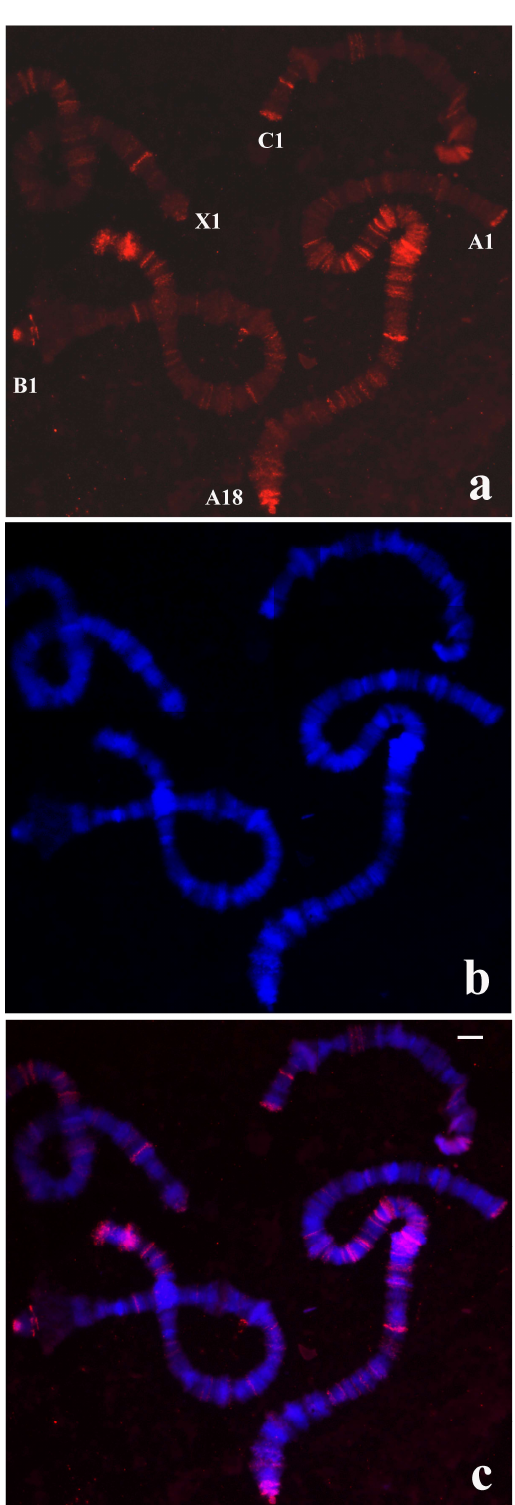
Figure 6. ( a ) Localization of the probe (red signal) synthesized with DNA from a microdissected chromosome end A-1 of T. pubescens in polytene chromosomes of R. americana . ( b ) Chromosomes stained with DAPI and ( c ) the corresponding merged signals. Chromosome ends labelled by the probe are identified. Bar = 20 µ